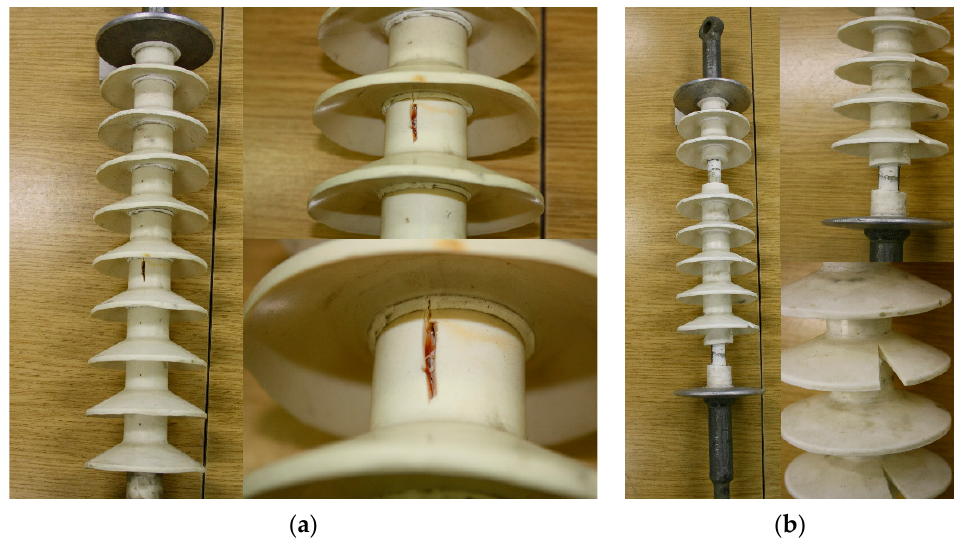
Figure 4. Damaged insulator (LK70/35): ( a ) with damage to the fiberglass rod and polymer shell and ( b ) with a damaged polymer shell and water in the area of the end fitting .